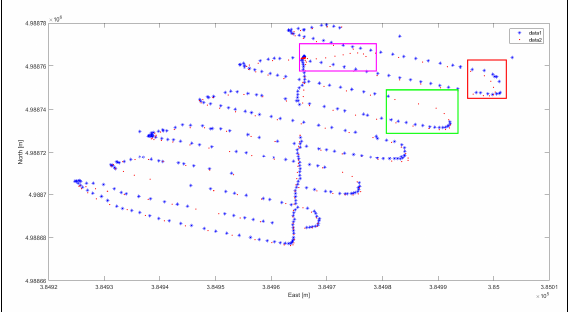
Figure 14. Comparison of East and North coordinates between the GNSS track (red), used to measure the acquisition points of the images, and the estimated position of the images (blue), after the image processing. In the red rectangle is shown the area with the greatest differences between measured coordinates; in the green and magenta box are highlighted cases in which images were not